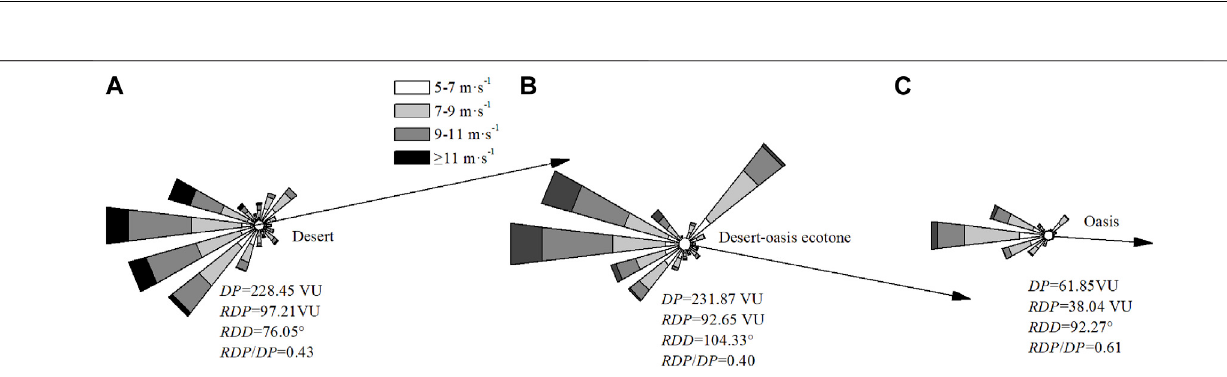
FIGURE 5 | Sand drift potential for the (A) desert, (B) desert – oasis ecotone, and (C) oasis during the experimental period of time. The calculated resultant drift potential (RDP) and resultant drift direction (RDD) are shown in black arrow.